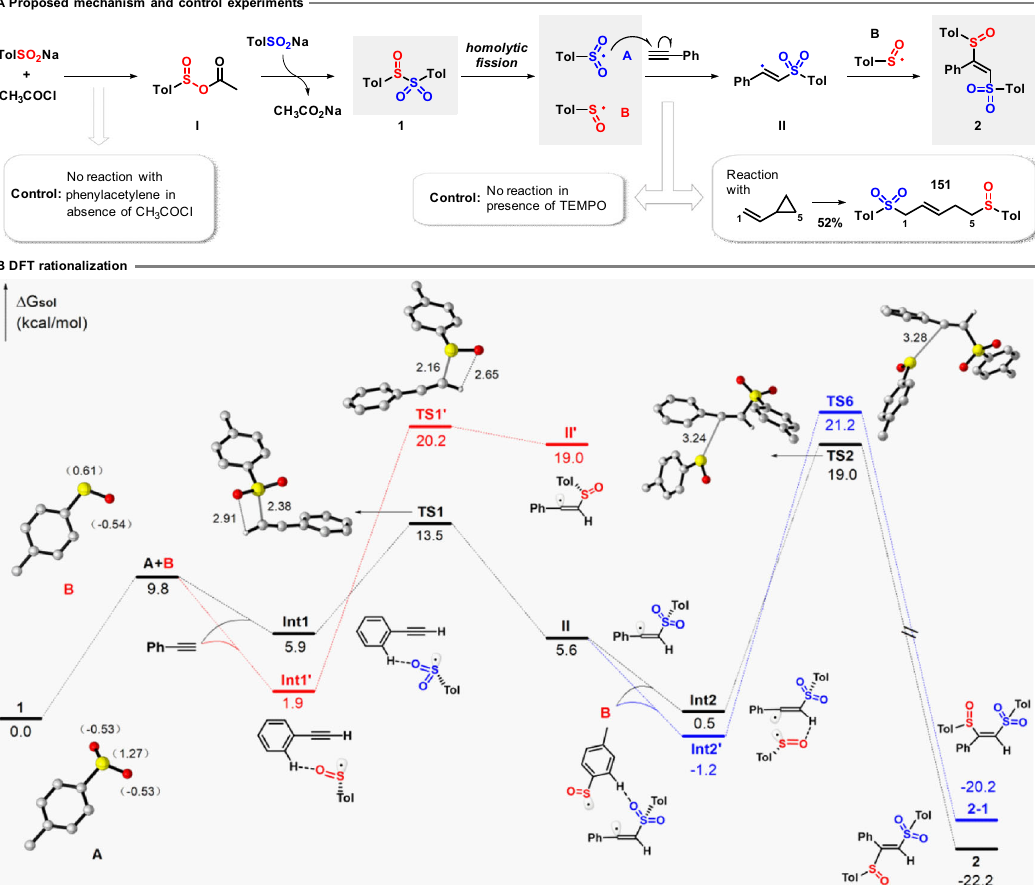
Fig. 6 Proposed mechanism and theoretical calculation research. A Proposed mechanism and experimental support for a radical pathway; B DFT calculations and graphical representation of the proposed mechanistic pathway. The energies are in kcal mol − 1 and represent the relative free energies calculated at the SMD-B3LYP/6-31 + G(d,p) level in chloroform. The preparation of 1 : TolSO 2 Na (1.8 mmol), CH 3 COCl (1.2 mmol), CHCl 3 (3 mL), N 2 , rt, 2 h. The radical suppression reaction: phenylacetylene (0.3 mmol), TolSO 2 Na (1.8 mmol), CH 3 COCl (1.2 mmol), TEMPO (0.9 mmol), CHCl 3 (3 mL), N 2 , 40